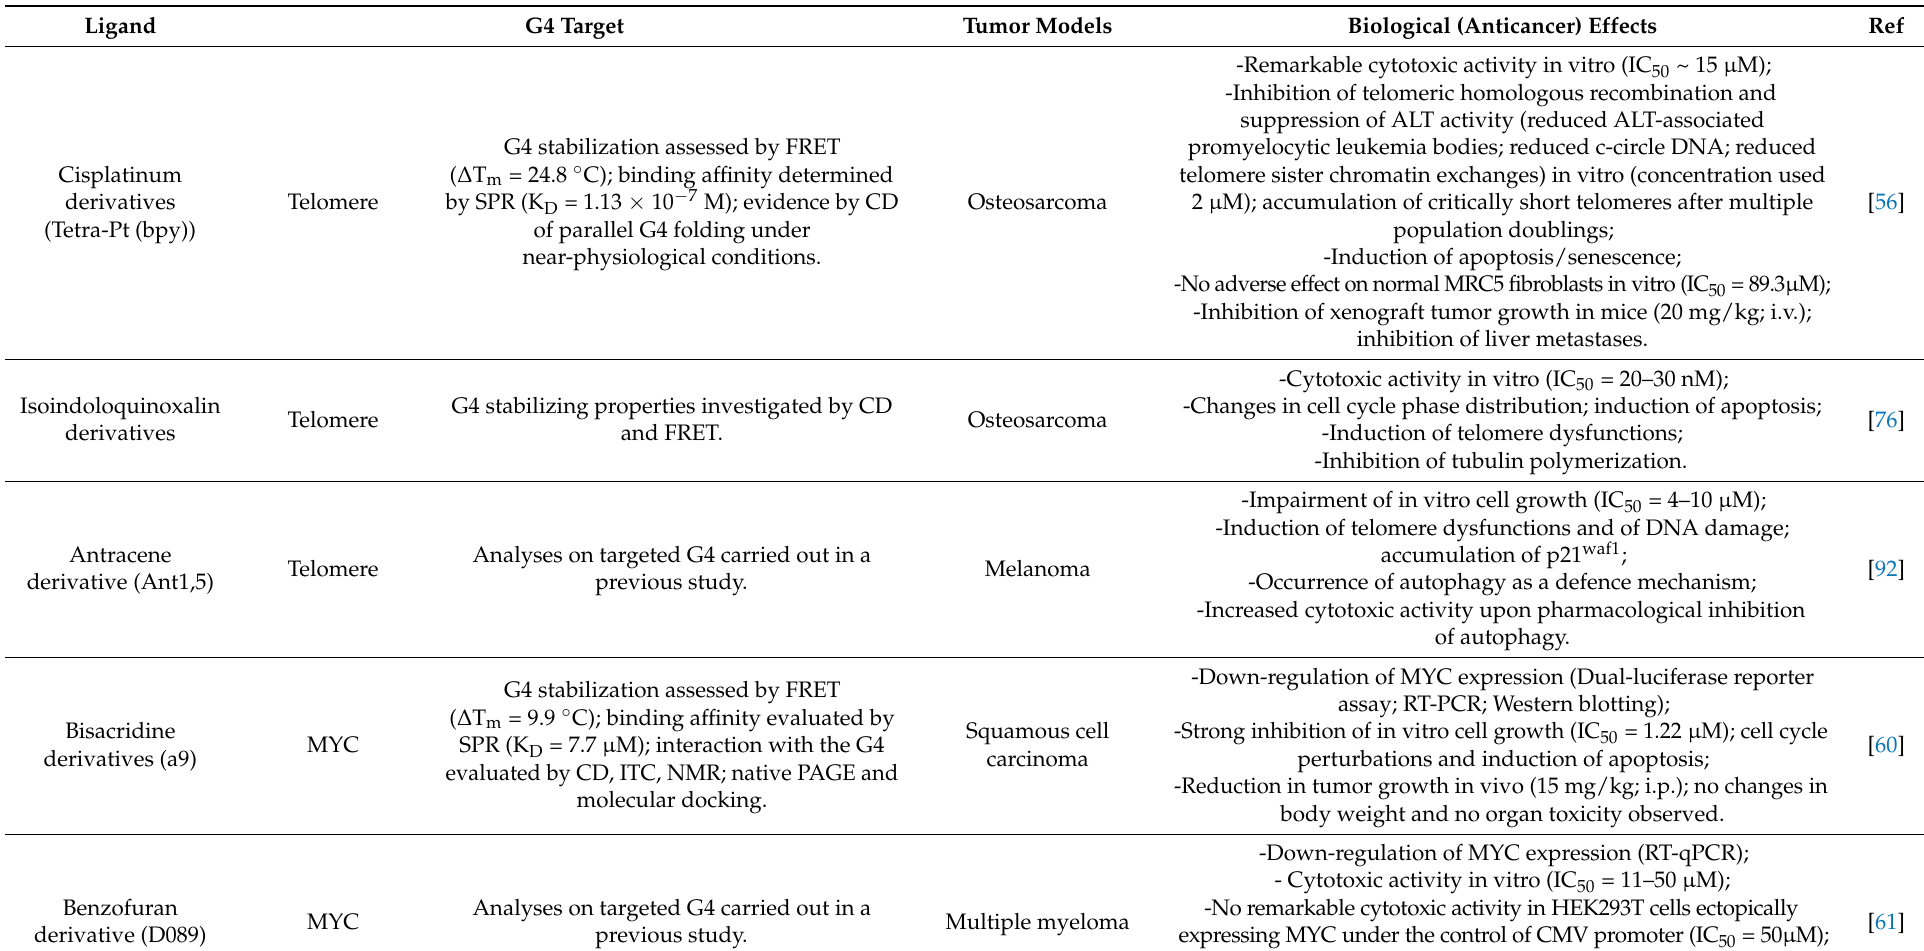
Table 1. Summary of the biological effects of G4 ligands from selected studies discussed in the main